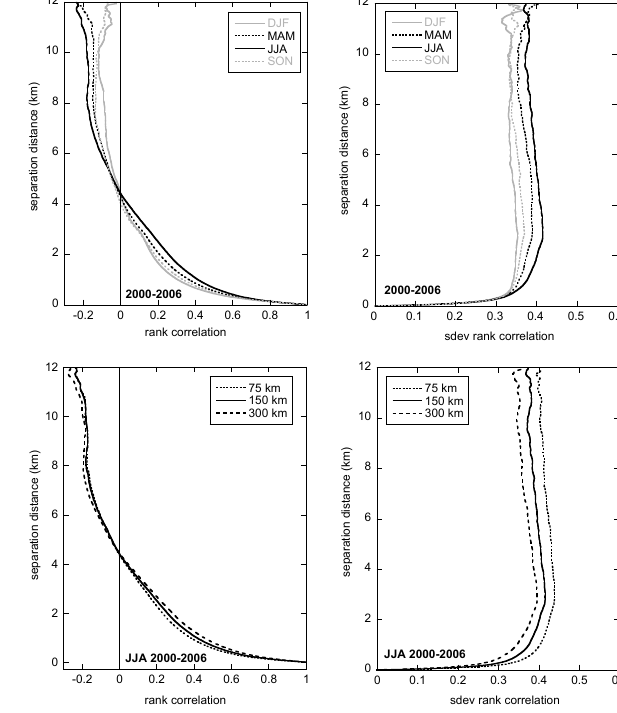
Fig. 2. As in Fig. 1, but for rank correlations. distance is faster for winter, followed by fall, spring and sum- mer. In other words, cloud fraction overlap is most random in the winter and least random (most maximum) during the summer. Since convective activity is greatest during the sum- mer while winter cloudiness is dominated by frontal systems, the conclusion is that convective clouds are more maximally overlapped than frontal clouds. This was also found by Mace and Benson-Troth (2002) and Naud et al. (2008). The first of these papers showed the seasonal cycle of alpha at select separation distances over the same observation site, but from a data set of coarser temporal and vertical resolution derived independently from the same suite of instruments used in MI- CROBASE. Our results also indicate that the variability (standard devi- ation) of alpha profiles follows in general the order of degree of random overlap: the alpha profile with the smallest val- ues (DJF) is also the most variable; during summer the alpha values are larger (more maximally overlapped) and the dis- tribution of alpha values is more narrow. This seems reason- able – if random overlap is produced by independent clouds layers at various heights, then we expect to get many cases of chance alignments between layers on a per segment basis, thereby injecting a random element of “maximum overlap” and increasing the variance of alpha. In contrast, maximum overlap cases produced by convective systems with strong vertical coherence are not expected to produce random over- lap by chance, unless there is a strong vertical wind